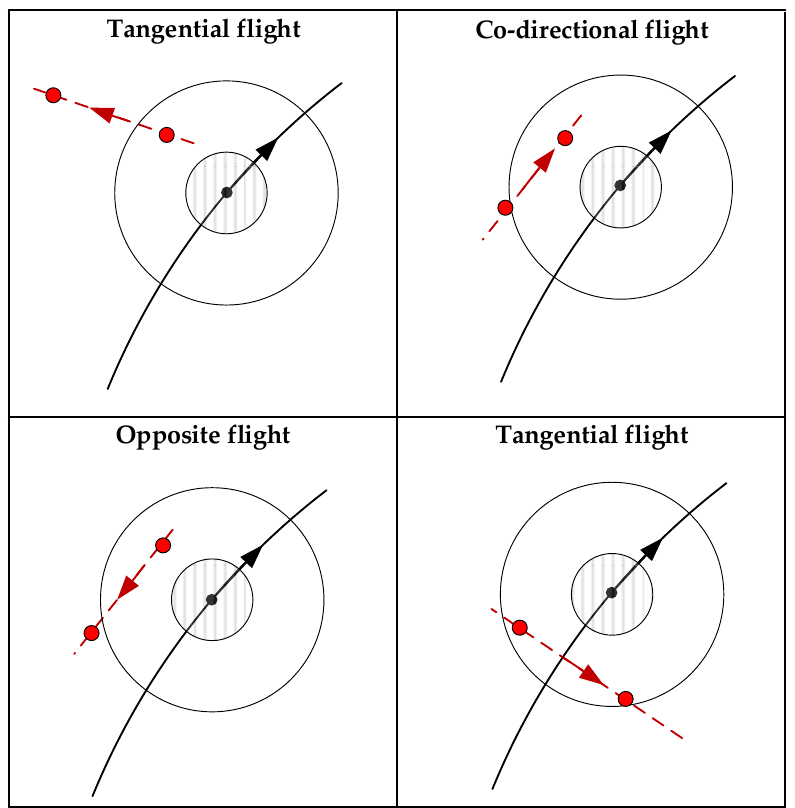
Figure 5. Relative motion between satellite and target.